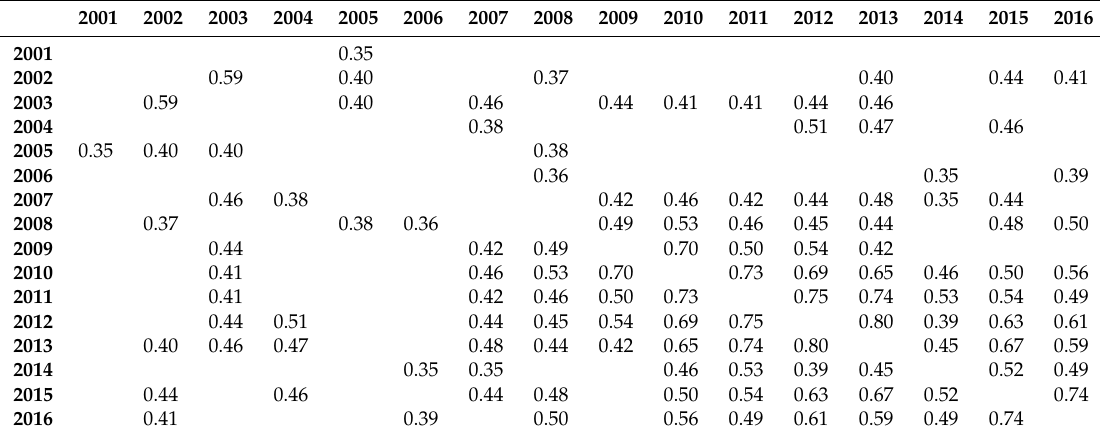
Table 2. Confirmed linear relation between results of CV-TOPSIS method for period of years 2001–2016 (variant I.).